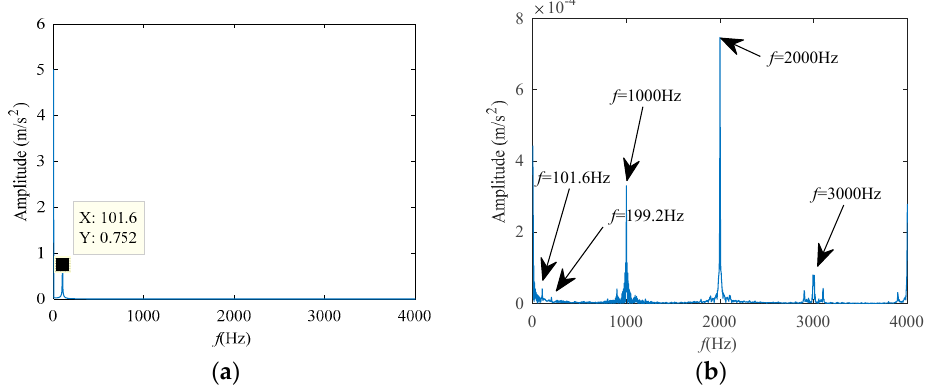
Figure 5. The Amplitude-Modulation signal. ( a ) Time-domain waveform. ( b ) Frequency spectrum.